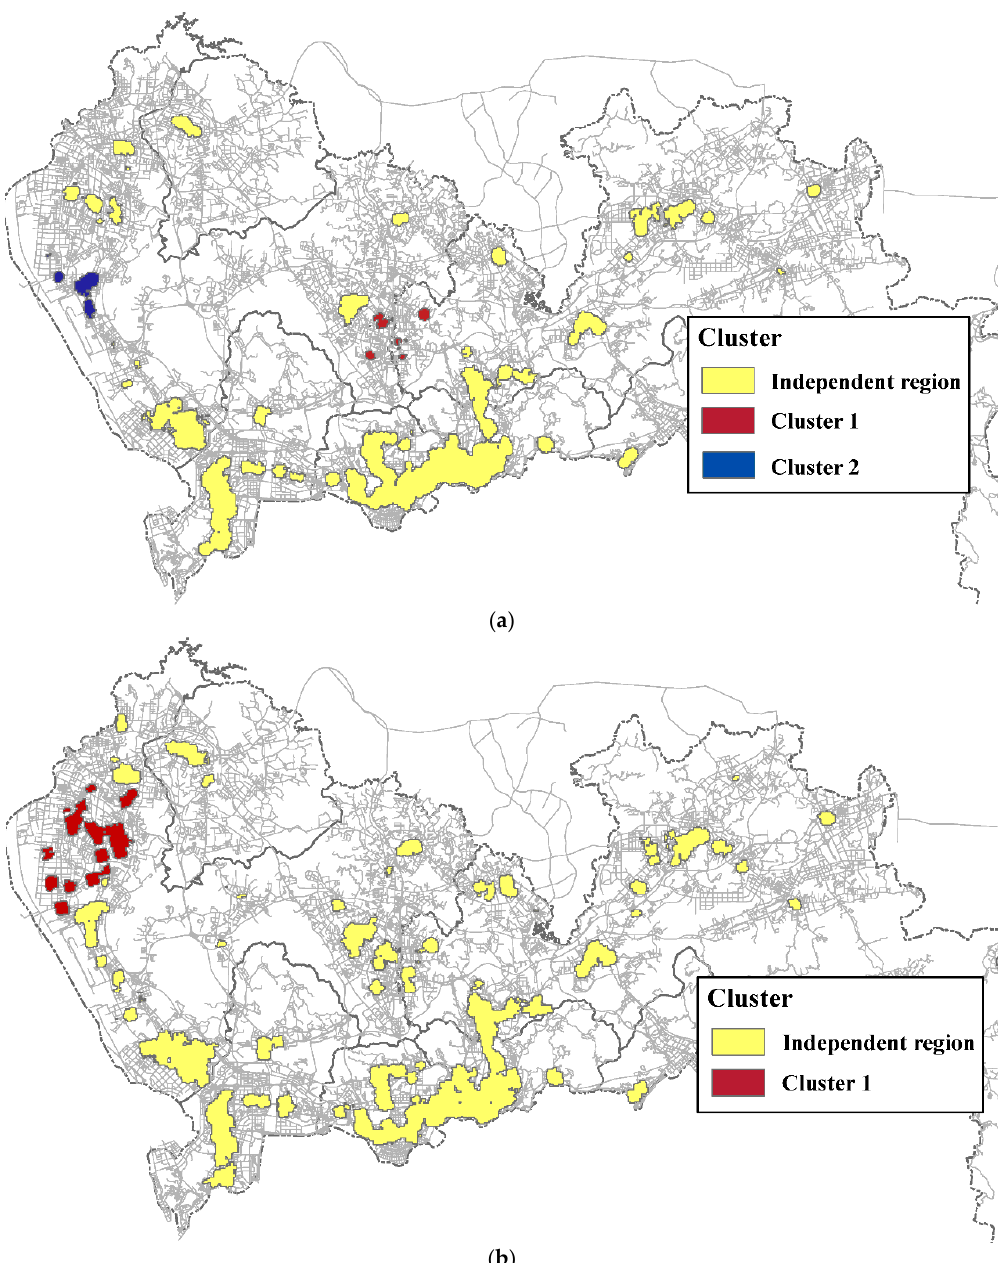
Figure 11. Results of identifying and clustering prevalent regions using a bandwidth of 600 m, for the: ( a ) size-2 pattern {bank, retail store}; and ( b ) size-3 pattern {bank, retail store, hotel}.